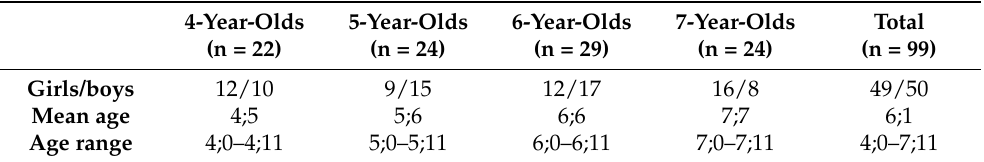
Table 1. Participants in the TD sample. Number of participants, sex, mean age (years; months) and age range (years; months) per age